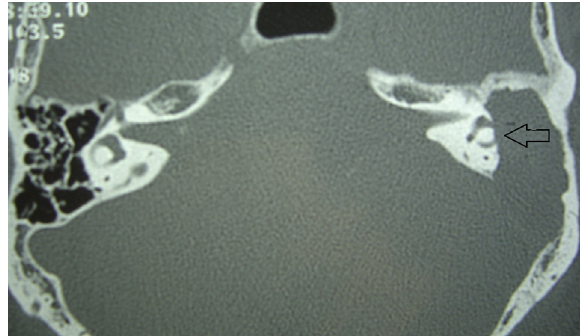
Figure 1 Temporal bones CT, axial view. The arrow shows ero- sion of the lateral semicircular canal on the left, in a patient with CCOM. Note : posterior erosion in the mastoid, adjacent to the sigmoid sinus.